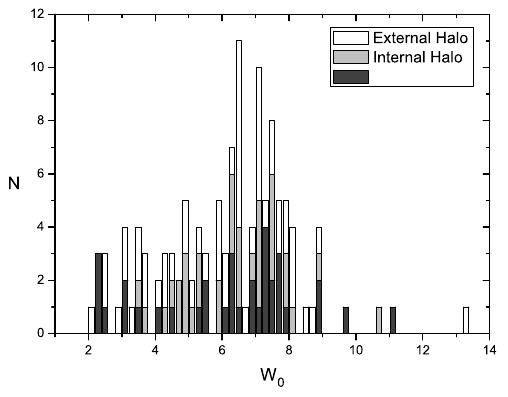
Figure 5: W 0 distribution of astronomical popula-